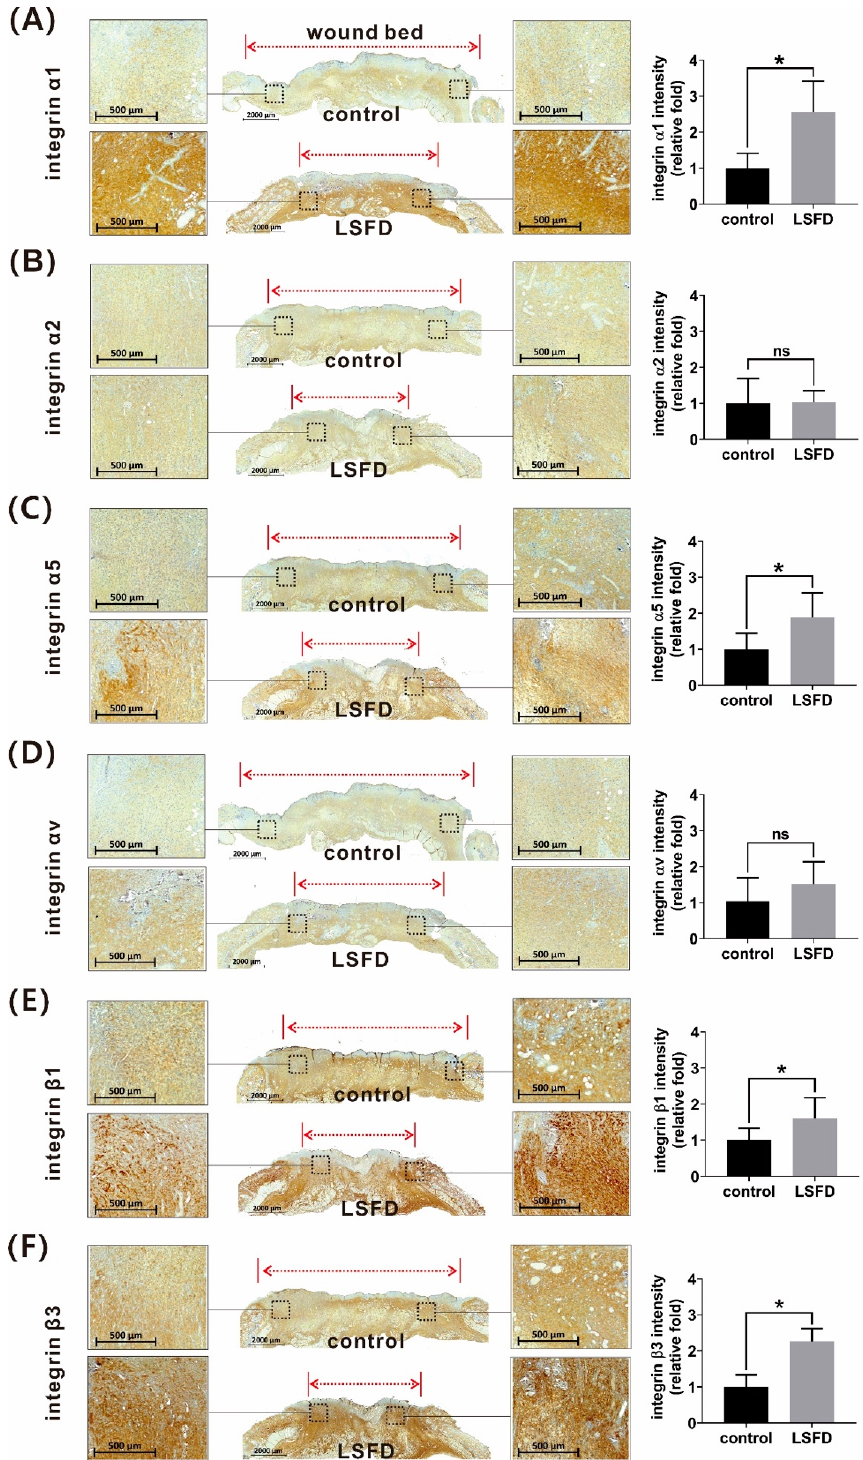
Figure 7. Immunohistochemistry staining and quantitative representations of the relative fold difference in the expression of different integrins in rat burn wounds treated with β -sheet lyophilized silk fibroin dressing (LSFD) and untreated burn wounds (control); ( A ) integrin α 1; ( B ) integrin α 2; ( C ) integrin α 5; ( D ) integrin α v; ( E ) integrin β 1; ( F ) integrin β 3. Data are presented as the mean ± standard error of the mean ( n = 6; * p < 0.05).